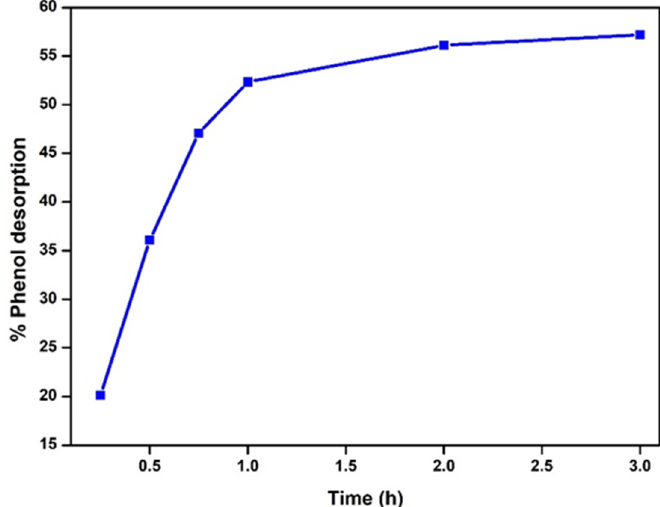
Figure 3. The % desorption of phenol over time with the use of 5% ( v / v )